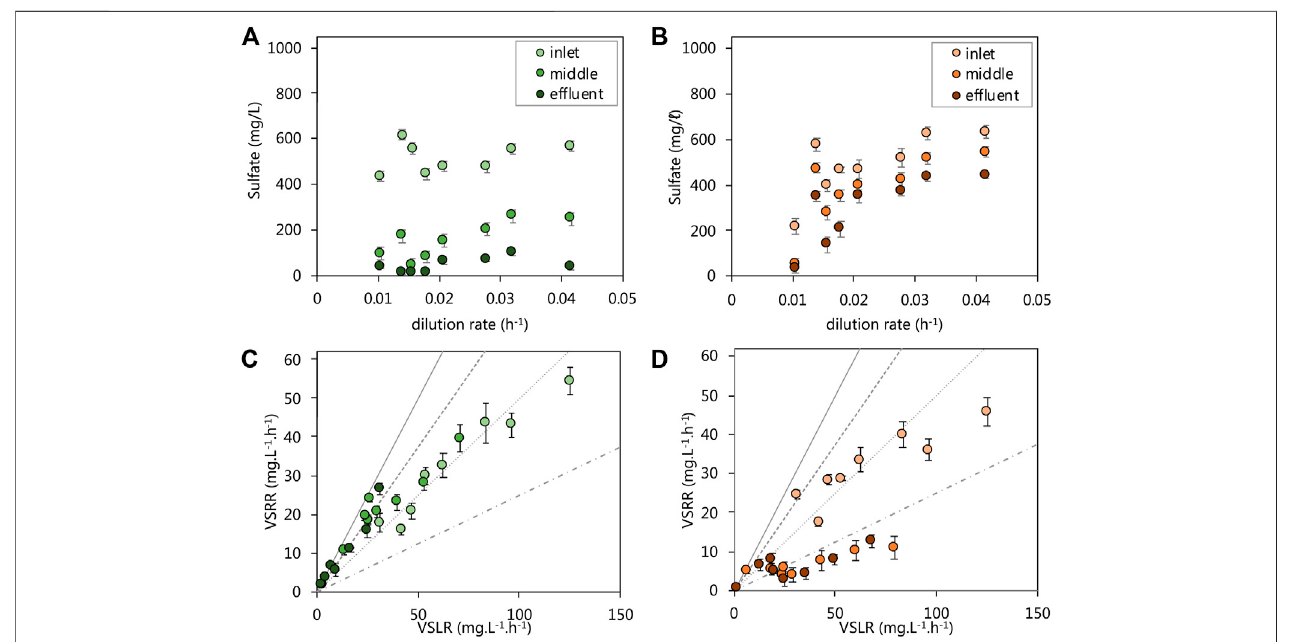
FIGURE 2 | Steady-state residual sulfate concentration leaving each zone of the (A) lactate and (B) acetate reactors and the VSRRs achieved by each zone of the (C) lactate and (D) acetate reactors against the applied VSLRs. Sulfate conversion can be visually be determined through comparisons with lines plotted: 100% conversion – solid line, 75% conversion – dashed line; 50% conversion – dotted line; 25% conversion – composite dotted-dashed line. Error bars represent one standard deviation from the mean ( n > 4).